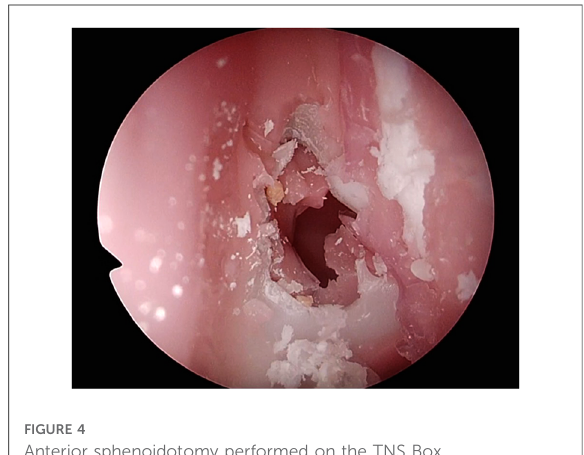
FIGURE 4 Anterior sphenoidotomy performed on the TNS Box.